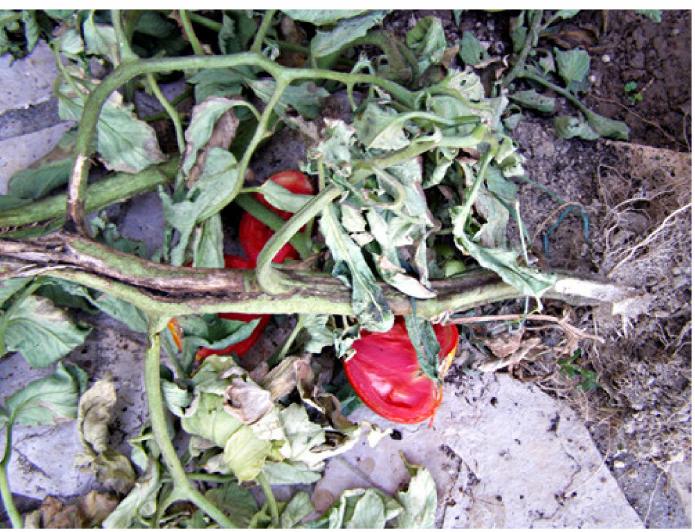
Figure 6. Wilting symptoms caused by Verticillum dahliae (Courtesy of Aida Kohni´c, Dušica doo, ˇCapljina, Bosnia and